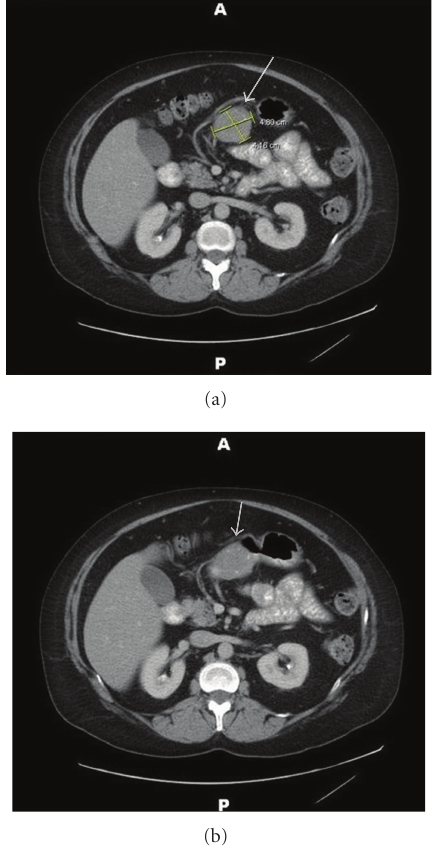
Figure 2: Contrast-enhanced CT showing a round, well-defined, and homogeneously enhancing mass arising from the antrum of the